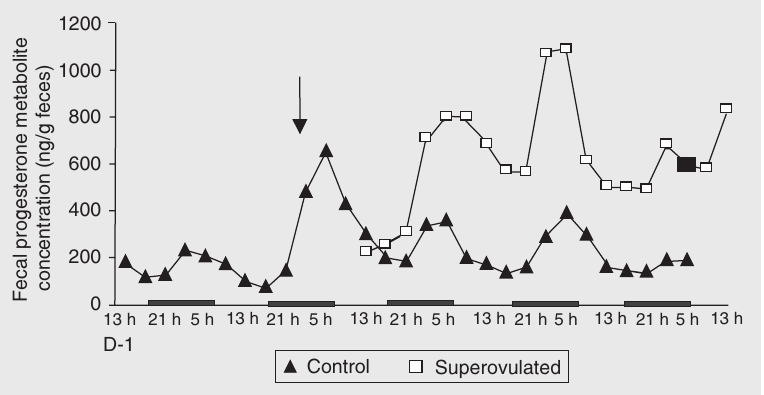
Figure 2. Changes in mean fecal progesterone metabolite concentration during the 4-day estrous cycle of two groups of adult female hamsters. Samples were collected at 4-h intervals throughout the cycle. The day after ovulation was designated as day 1 (D-1) of the cycle. The arrow indicates the estimated time of ovulation. The black square indicates the time of hCG injection into superovulated females. Dark bars on the x-axis indicate “lights out”. Each value represents the mean of 7 observations (normally